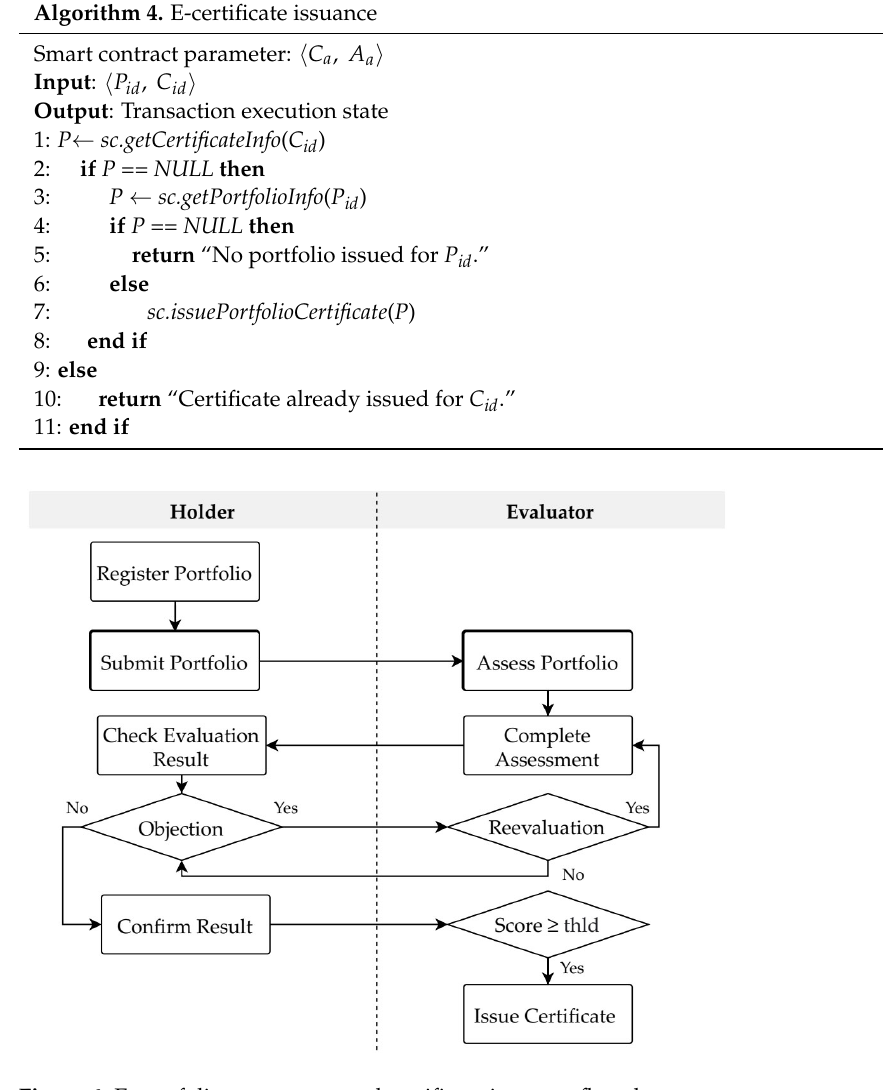
Figure 6. E ‐ portfolio assessment and certificate issuance flowchart. Algorithm 4. E ‐ certificate